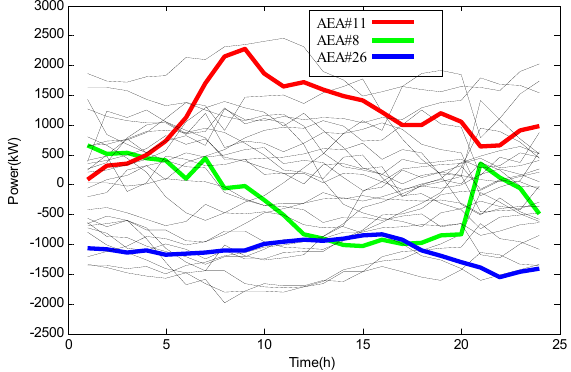
Figure 6. 24-h output profiles of 29 AEAs in the test system.